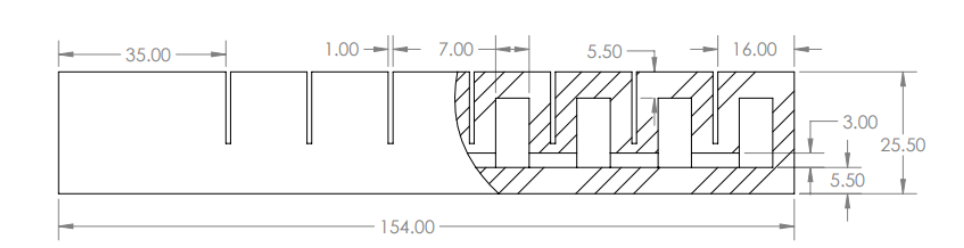
Figure 3. Measurements of a soft actuator’s individual component.